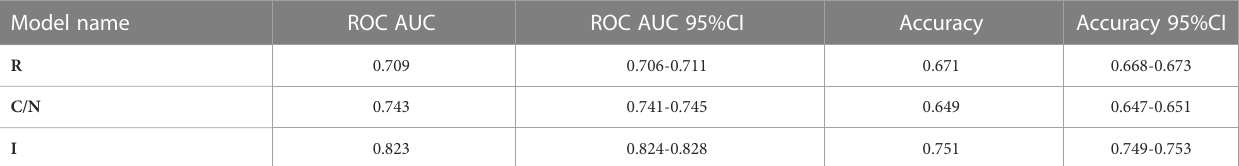
TABLE 4 Performances of the R, C/N and I models.